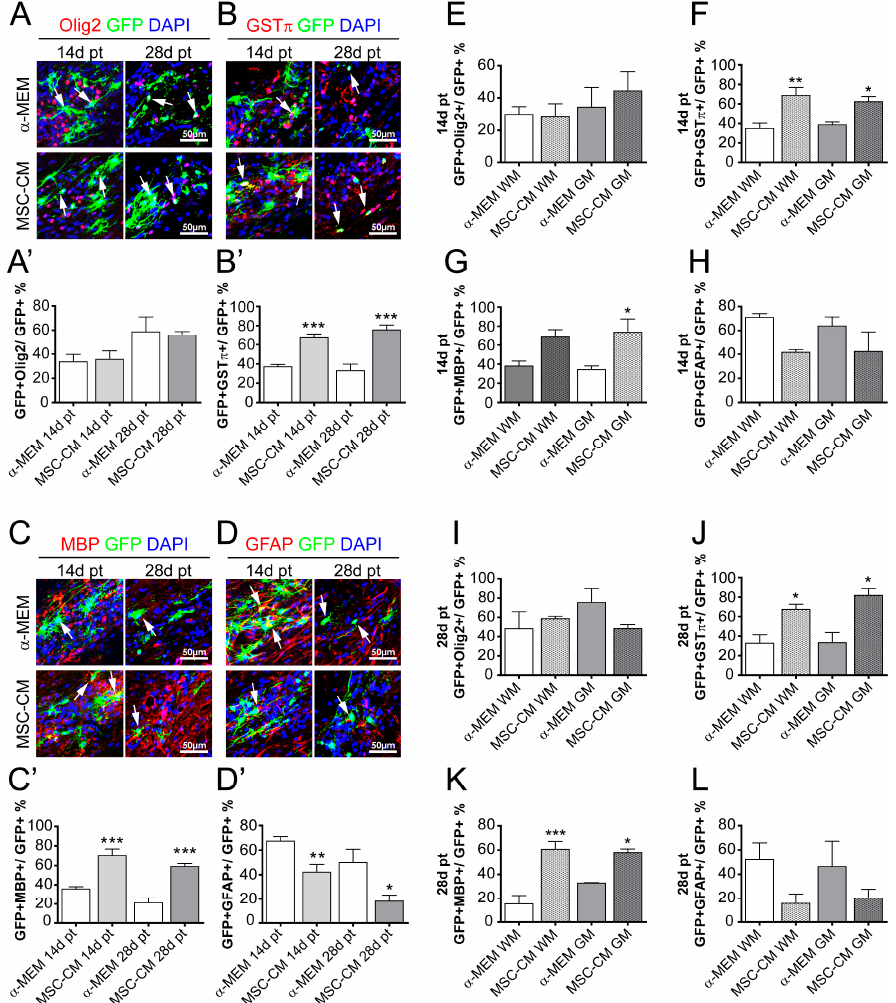
Figure 4. Accumulation of oligodendroglial characteristics in spinal cord-transplanted aNSCs. Representative pictures of GFP-positive cells expressing Olig2 ( A ), GST π ( B ), MBP ( C ), and GFAP ( D ) at 14 and 28 days post-transplantation and following α -MEM or MSC-CM pre-treatment. The corresponding quantifications (percentage of expressing cells over total number of GFP-expressing cells) are depicted in ( A’ ) for GFP/Olig2- in ( B’ ) for GFP/GST π -, in ( C’ ) for GFP/MBP-, and in ( D’ ) for GFP/GFAP-positive cells. (E-L) Quantification and distribution of transplanted GFP-positive cells pre-treated with α -MEM and MSC-CM within white matter (WM) and grey (GM) at 14 and 28 days post-transplantation. Statistical significance was calculated using a two-way ANOVA with Bonferroni posttest: * p ≤ 0.05, ** p ≤ 0.01, *** p ≤ 0.001 (for comparison between control α -MEM to MSC-CM). Arrows point to GFP-positive cells (green) expressing the respective marker proteins (red). Blue nuclei represent DAPI staining. Animal numbers ( n ): 4-6.